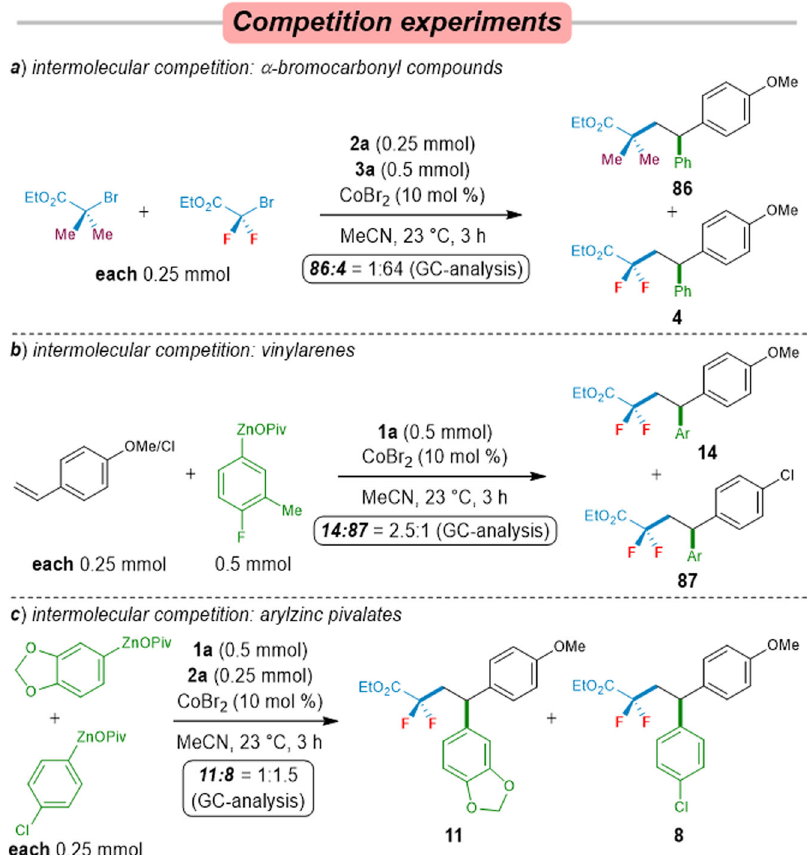
Fig. 5 Control experiments. a Competition experiments between different alkyl bromides. b Competition experiments between different vinylarenes. c Competition experiments between different arylzinc